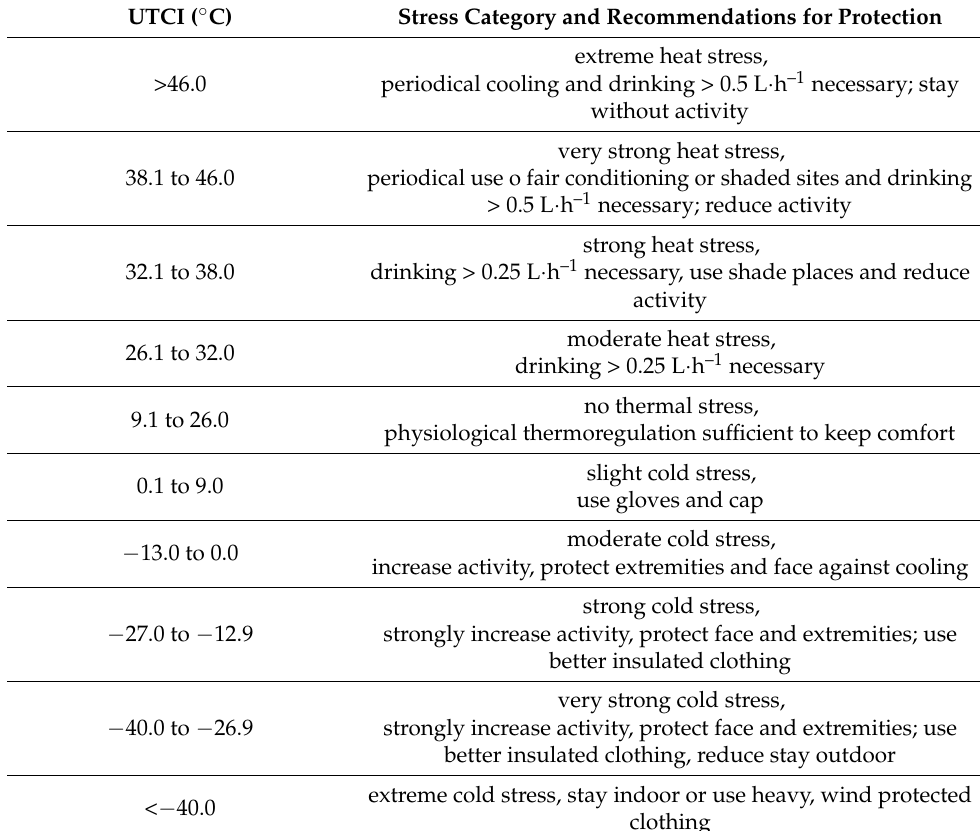
Table 1. Thermal stress categories based on the Universal Thermal Climate Index [65].